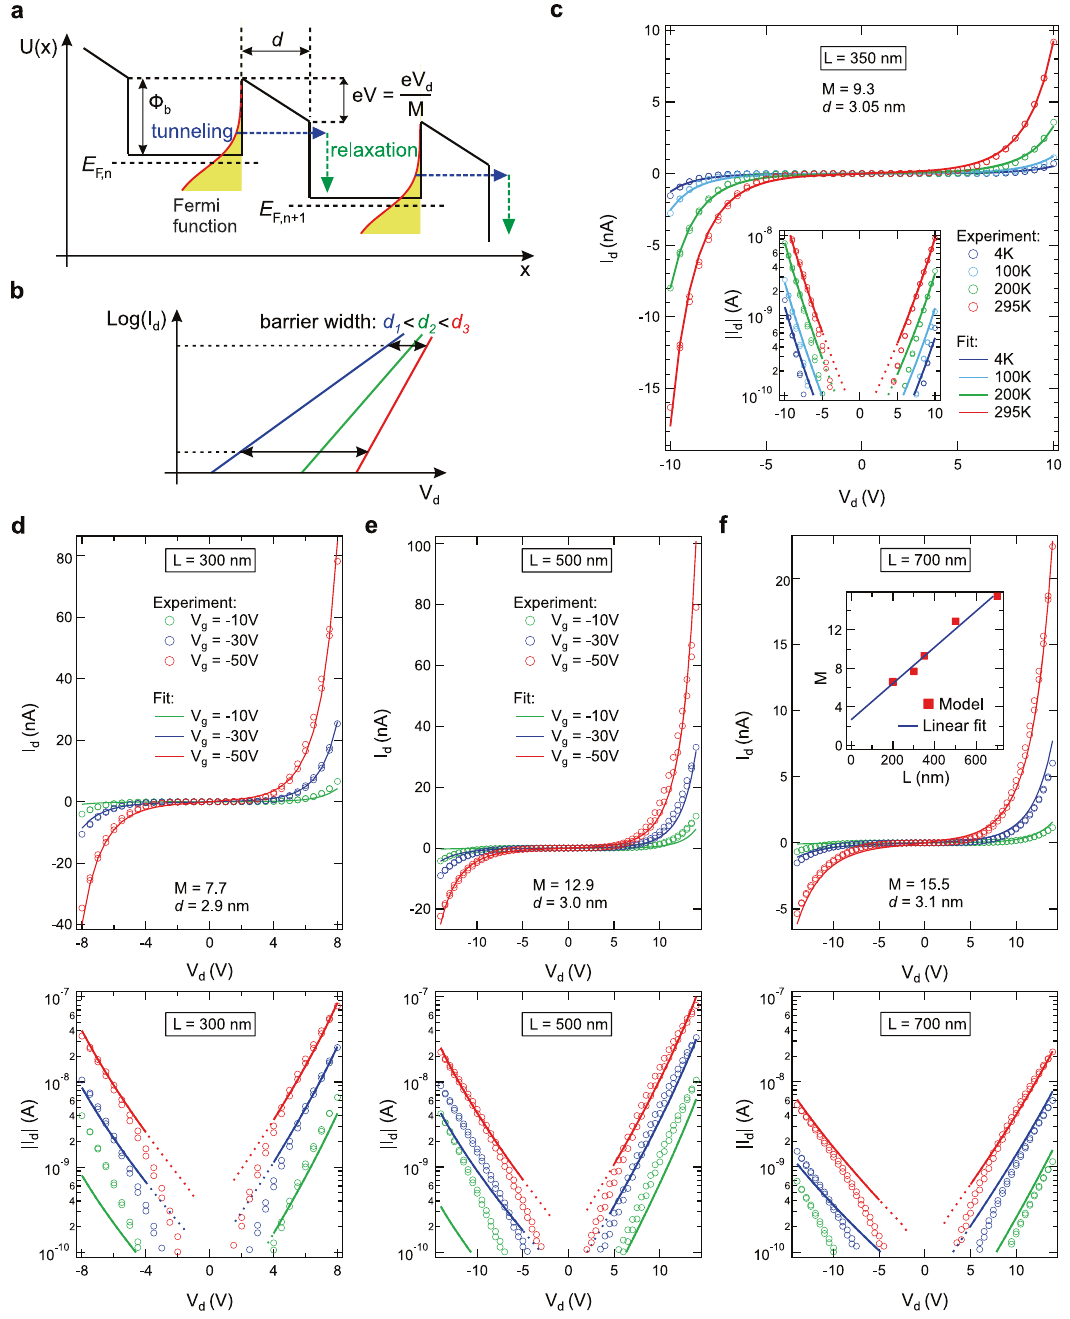
Fig. 4 Comparison of experimental and calculated I d – V d curves. a The energy diagram along one conducting channel of GNR heterojunctions. The tunneling through a barrier (blue arrows) followed by relaxation of the carrier (green arrows) is illustrated. The Fermi level of the n th barrier is indicated as E eV = eV M (where e is the electron charge and M is the number of barriers in the channel), is indicated F, n . The energy drop across one barrier, equal to d / Þ versus V I along with the barrier height Φ b and the barrier length d . b Sketch of log ð I d characteristics of three different barriers. At high d , the voltage drops d V I – V d across the barriers assume a narrower distribution (indicated by horizontal arrows). c Experimental (empty circles) and calculated (solid lines) d d curves of the 350 nm channel device at different temperatures between 4 and 295 K at V g = 0. The inset shows the I d – V d curves in a log scale. d – f Experimental (empty circles) and calculated (solid lines) I d – V d curves for devices with L = 300, 500, and 700 nm at V g = − 10, − 30, and − 50 V at 295 K in linear (top) and log (bottom) scales. The inset in f shows the M versus L dependence and its linear fi